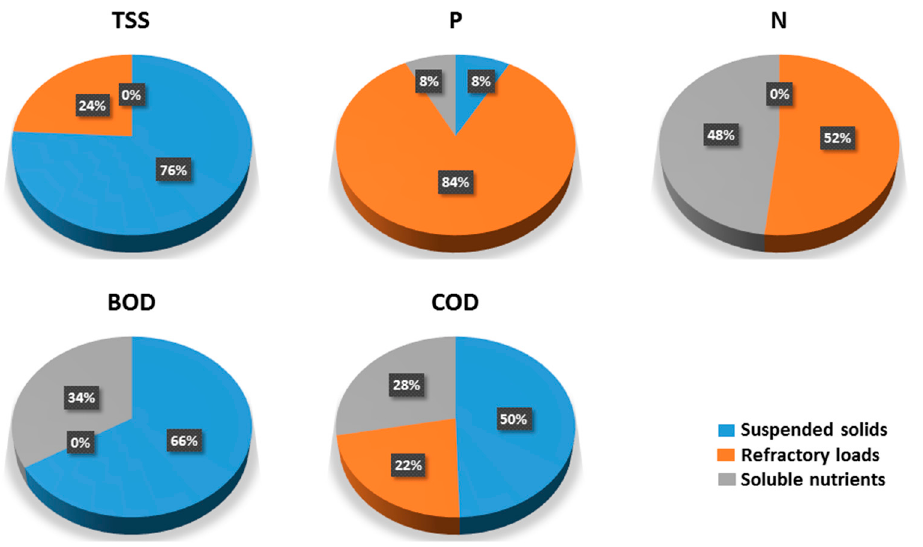
Figure 2. Average source contributions to WWTP e ffl uent loads. To outline the di ff erences between the investigated WWTPs the component scores are used for calculation of the source contribution to WWTP e ffl uent loads of each treatment plant (Figure